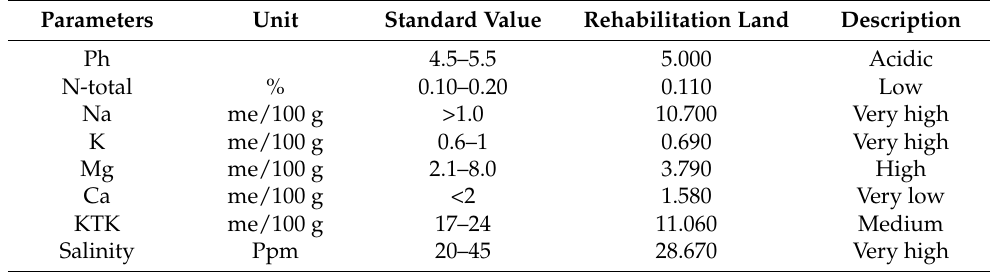
Table 14. Analysis of soil chemical properties for planting rehabilitation using